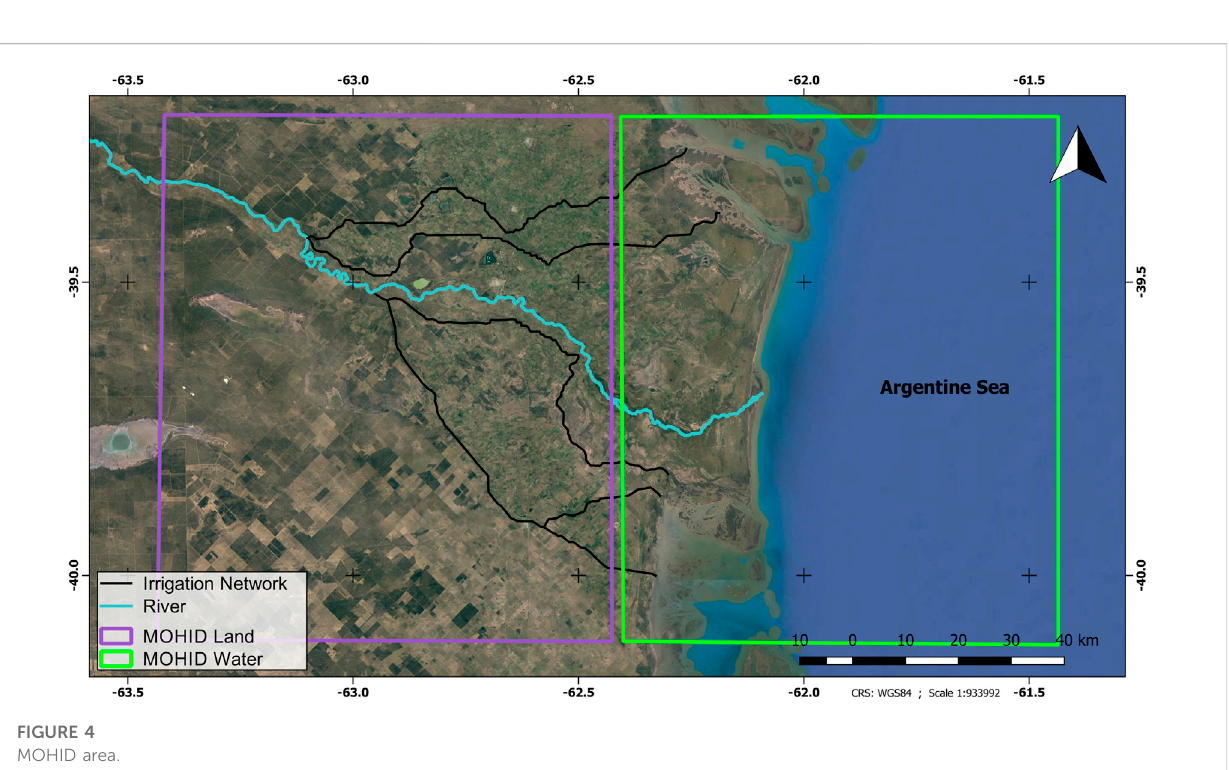
that are computed using a fi nite volume approach. The simulation domain, just like MOHID Water, is organized into a regular structured grid horizontal plane, and Cartesian type in